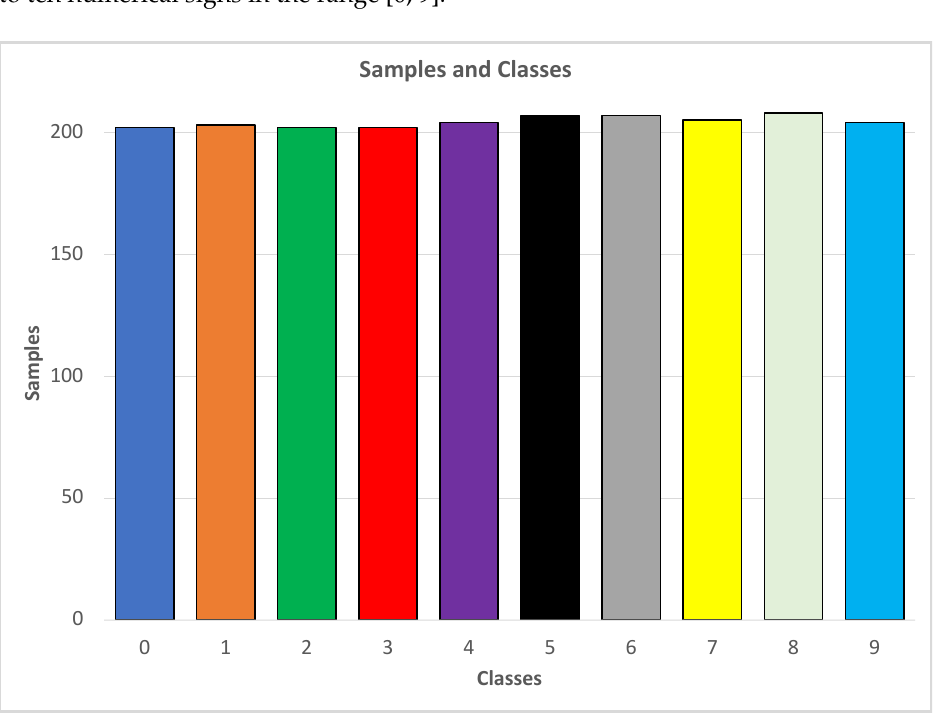
Figure 12. Classes from